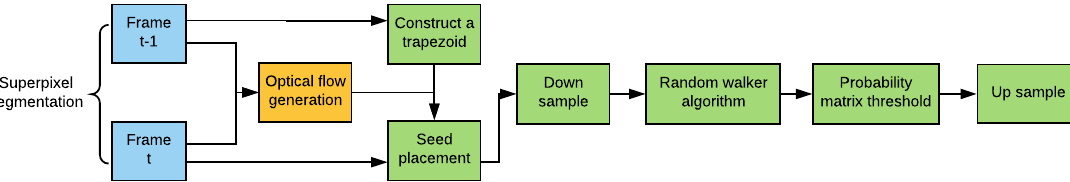
Figure 1. Flow diagram of the superpixel-level random walk algorithm at frame t